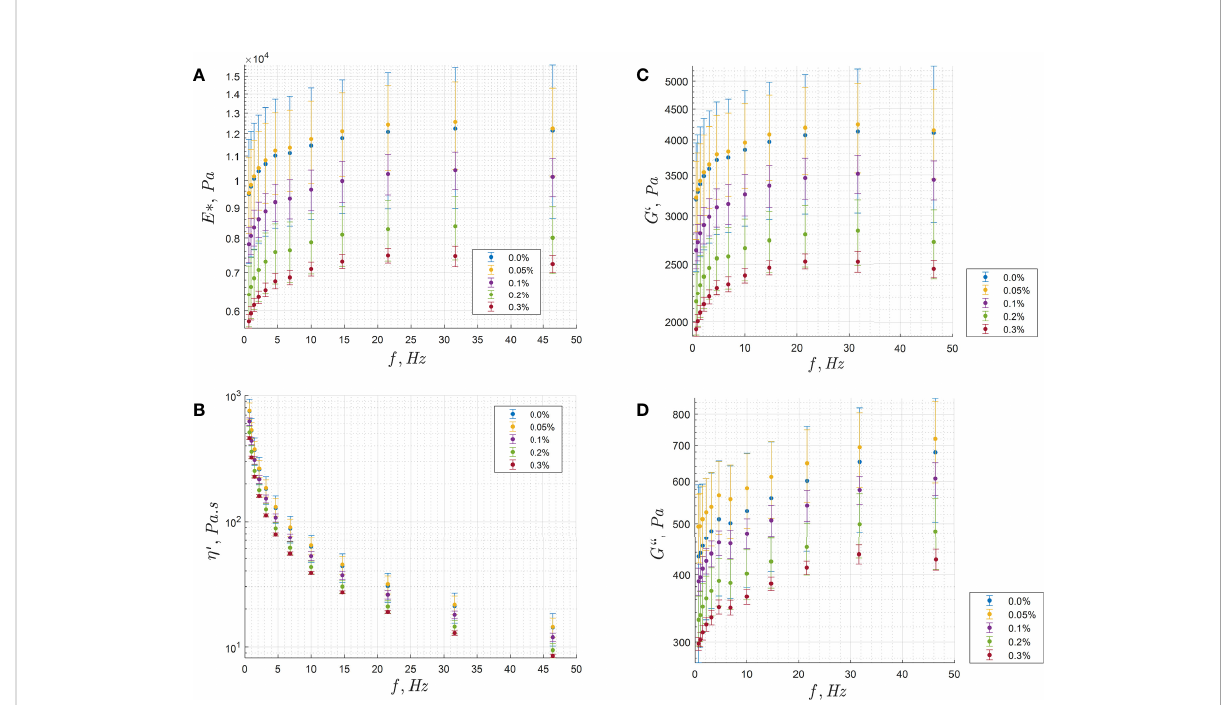
FIGURE 9 Rheometry analysis of a F8TAC18-PFOB TMM gel set. (A) Modulus of elasticity, (B) Dynamic viscosity, (C) Shear storage modulus, (D) Shear loss